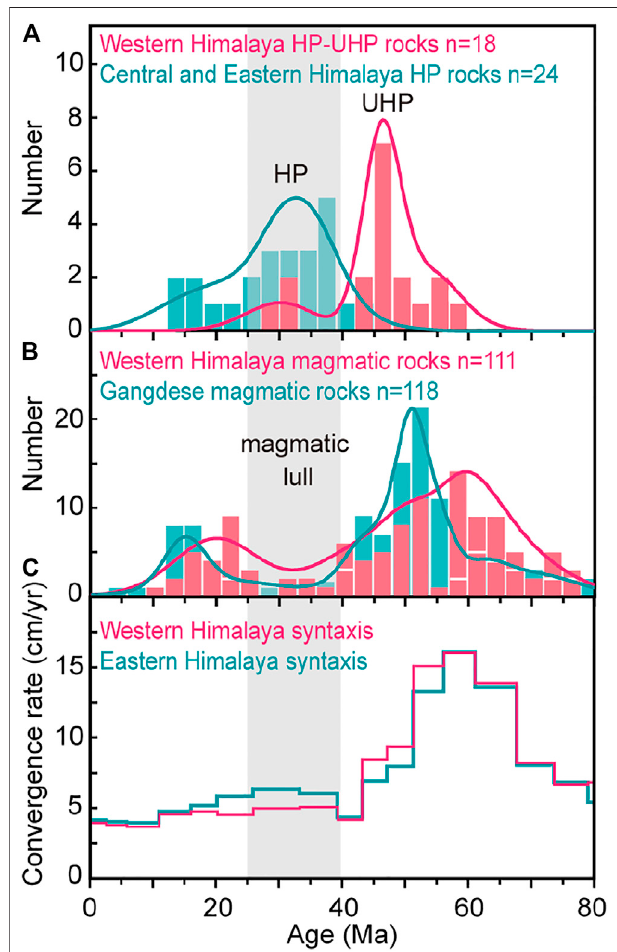
FIGURE7 |(A) Cumulative probability curve and histogram showing the peak metamorphic ages of the HP and UHP rocks in the western (red) and central-eastern Himalayas (green). (B) Cumulative probability curve and histogram for the crystallization ages of the western Himalaya (South Karakoram, Kohistan – Ladakh Arc, red), and Gangdese (green) magmatic rocks. (C) India – Asia convergence rates. Detailed data and sources are listed in Supplementary Table S6